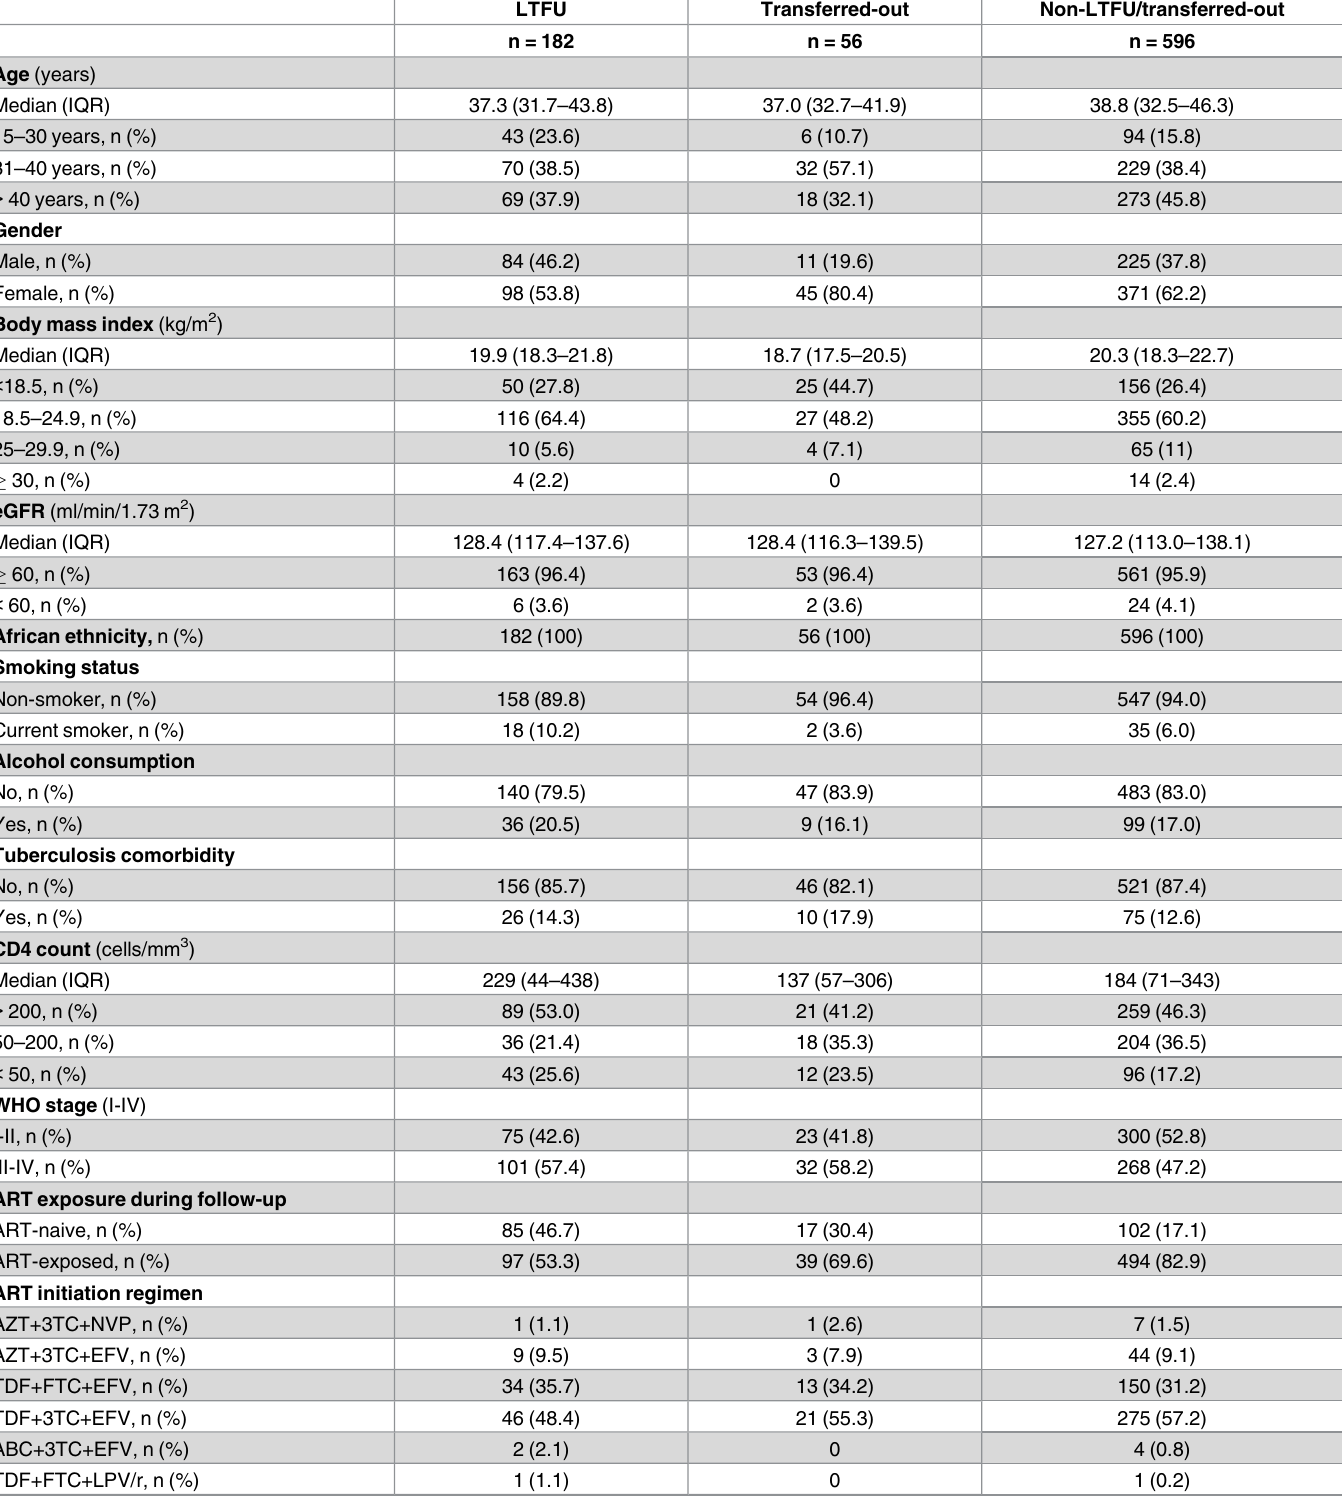
Table 2. Summaryof patient baseline characteristics according to patient follow-up